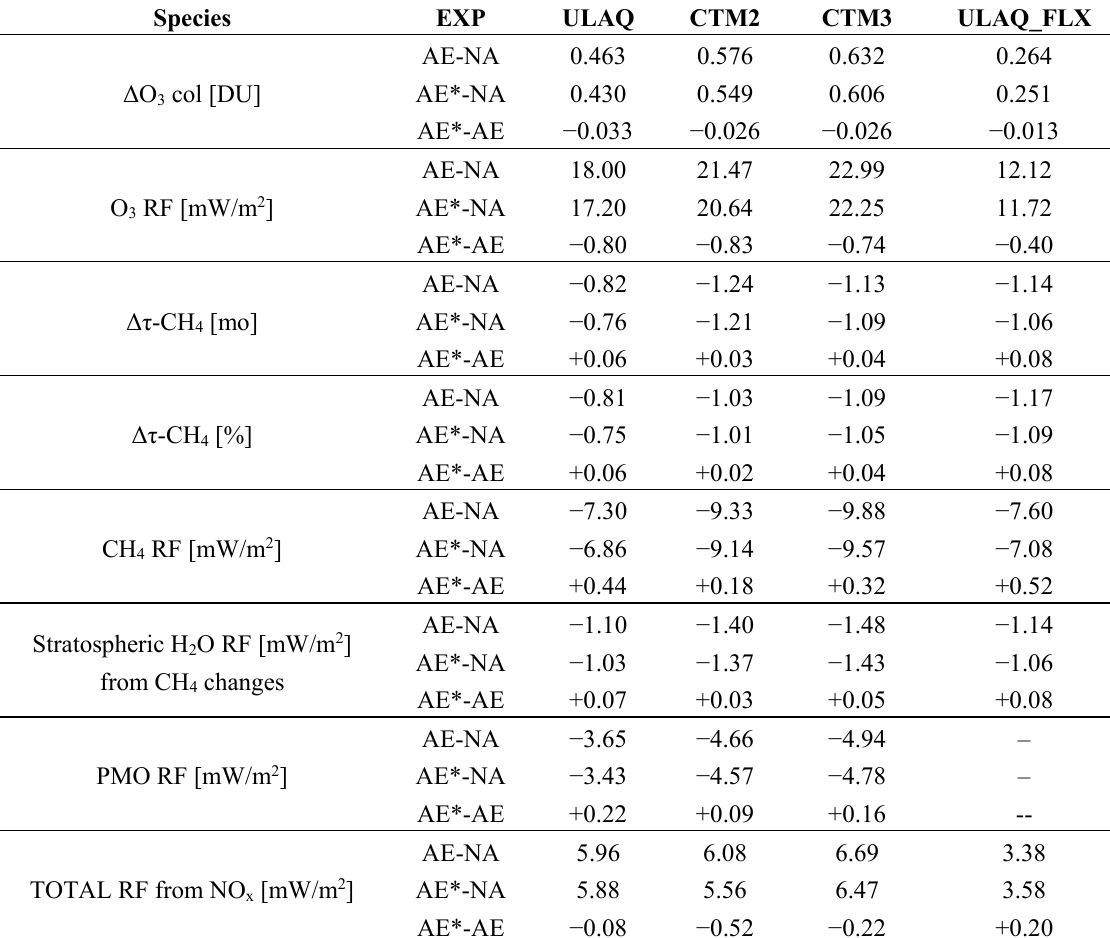
Table 5. Summary of NO x -related RF mean value terms: O 3 , CH 4 and PMO (primary mode ozone, i.e. , long-term ozone response). Ozone RF values are obtained as a mean from Oslo and ULAQ radiative code calculations. Differences are calculated between NA (experiment with no aircraft emission), AE (experiment with only gaseous emission [NO x +H 2 O]) and AE* (experiment with gaseous and particle emission [NO x +H 2 O+SO 4 ]). See text for details on the calculations of CH 4 RF, PMO RF and the stratospheric H 2 O RF induced by CH 4 changes. Note that for ULAQ_FLX, O 3 -RF includes both short-term and long-term (primary mode) effects, whereas for the other models, only short-term O 3 RF is included (long-term effects are then included in “PMO